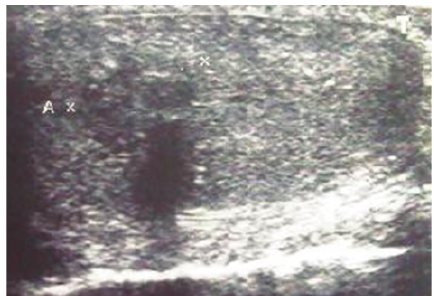
Figure 1: Testicular ultrasonography. Multiple hypoechoic areas in the testes. Both epididymides were normal.